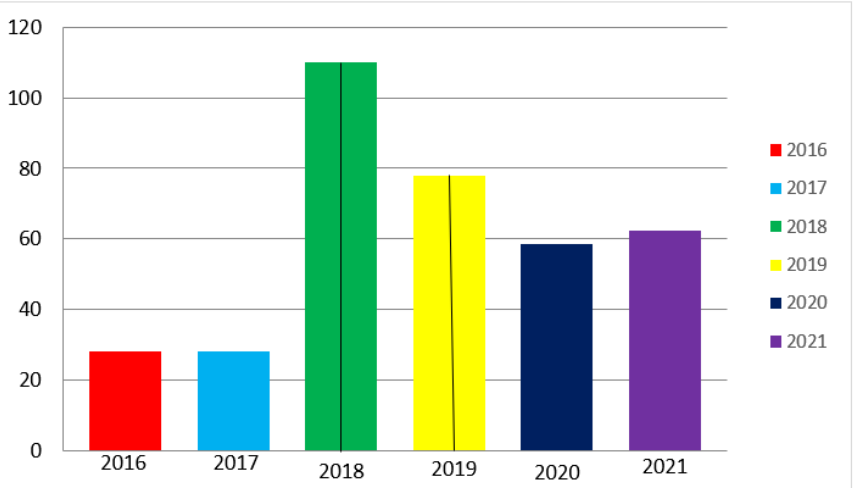
Figure 2. Distribution diagram of the number of articles on laser welding of dissimilar metals for 2016–2021 inclusively. Author’s own diagram.